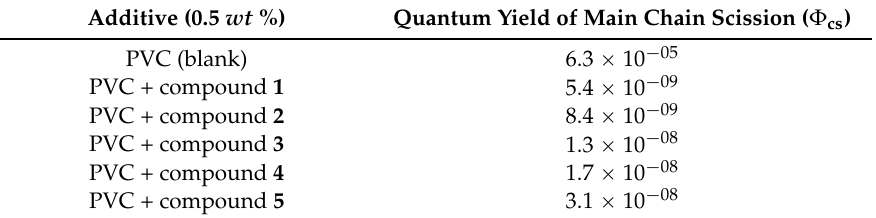
Table 2. Quantum Yield ( Φ cs ) for the chain scission for PVC films (30 µ m thickness) in the presence and absence of additives (0.5% by weight) after irradiation (250 h).